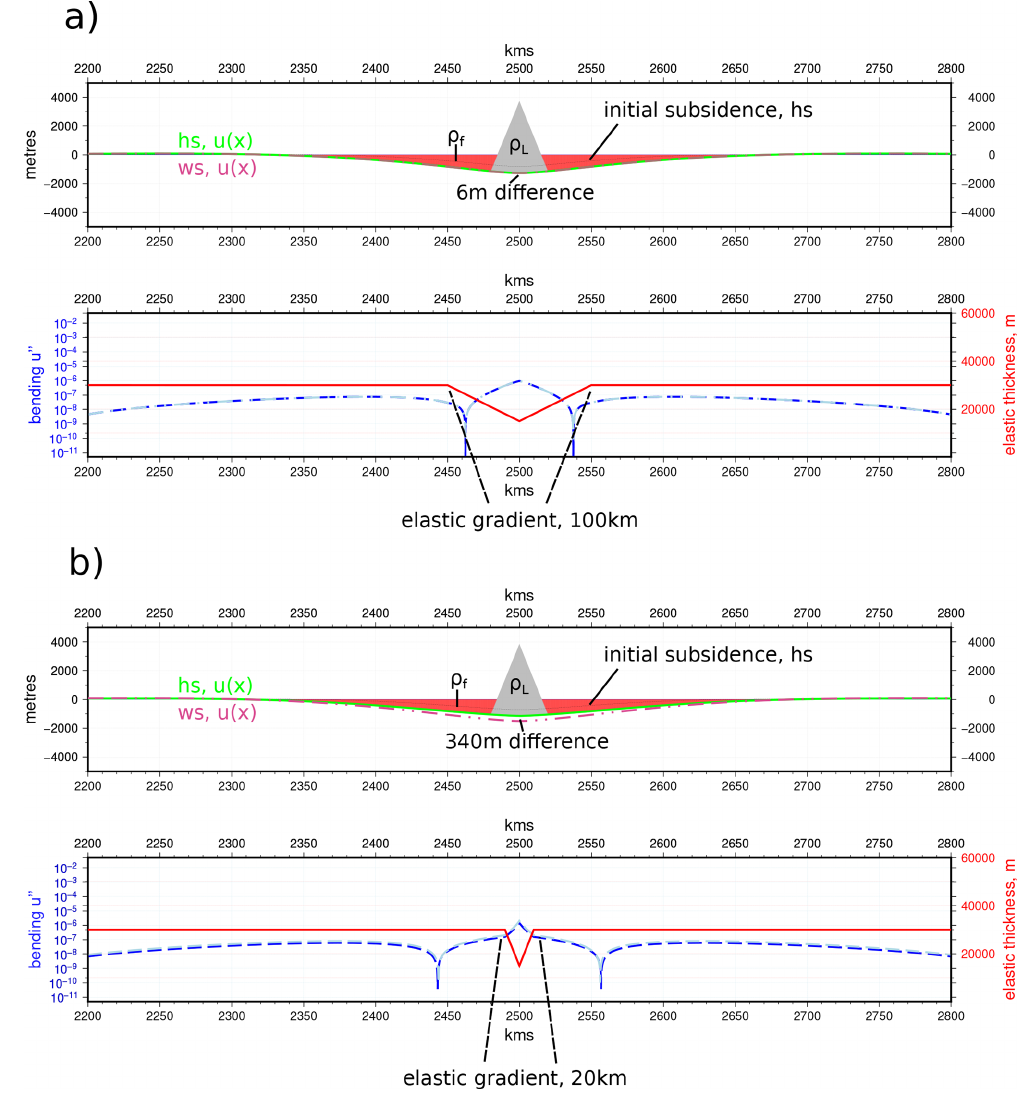
Figure 8. Piecewise linear variation of h(x) (for parameters used, see Table A1) with a (a) relatively gentle gradient, for which the whole- station and half-station schemes are in good agreement. (b) Sharper gradient for which there is a substantial difference between the whole- station and half-station methods. Figure prepared using GMT v6.0.0 (Wessel et al.,